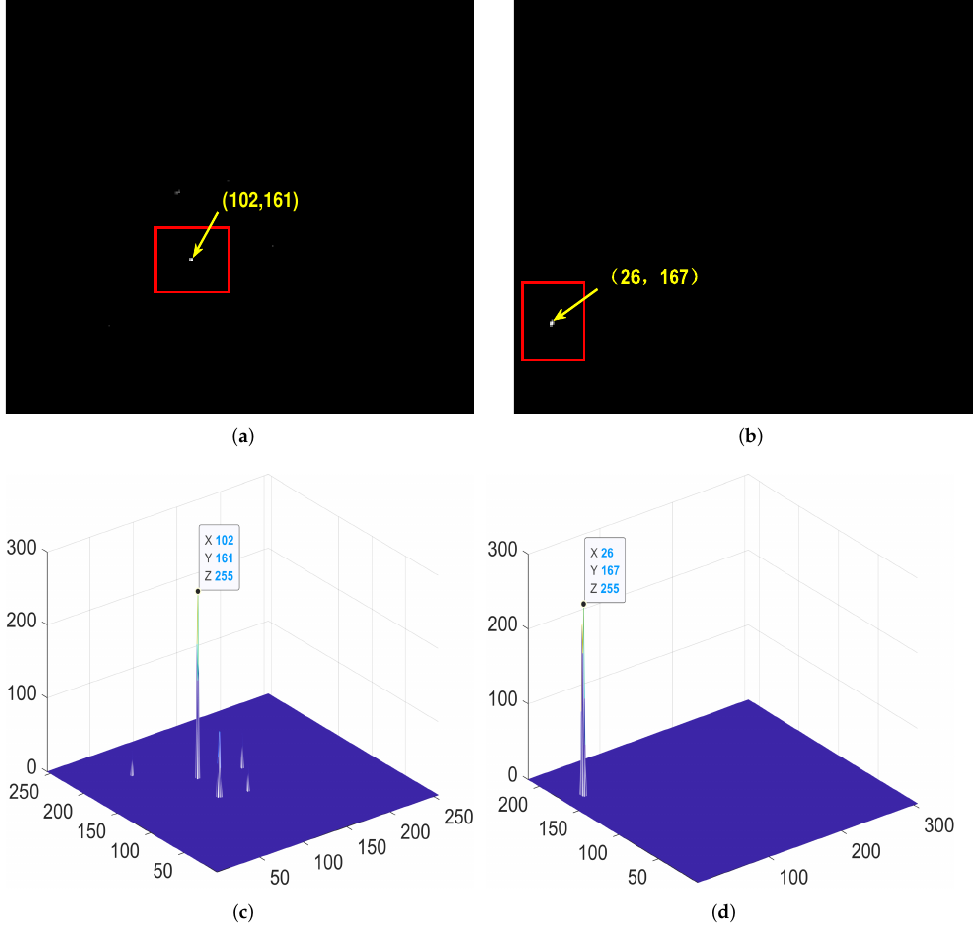
Figure 5. The TVWLR model detection results. ( a , b ) the target images processed by the TVWLR model. ( c , d ) the target images processed by the TVWLR